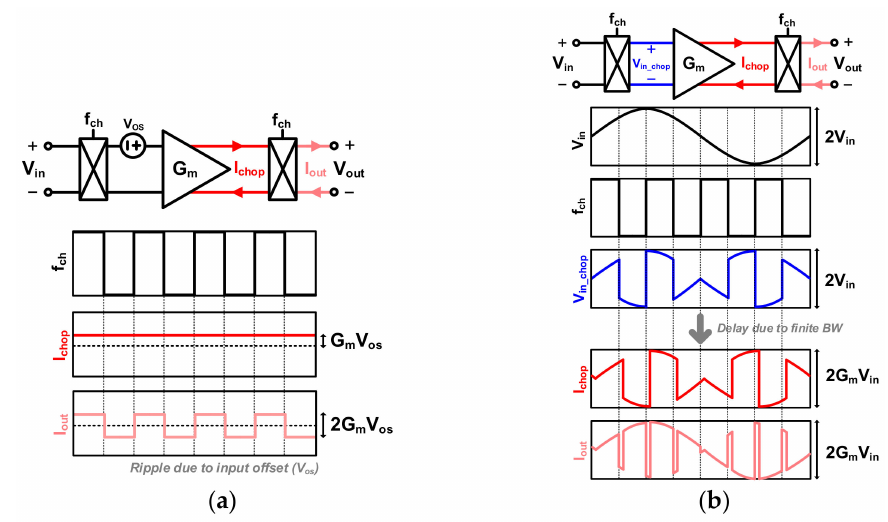
Figure 3. Drawbacks of the chopping technique: ( a ) ripple and ( b )